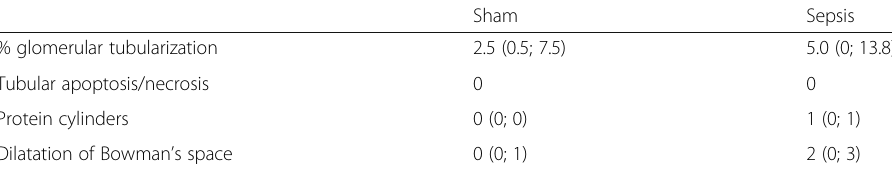
Table 1 Kidney histopathology score